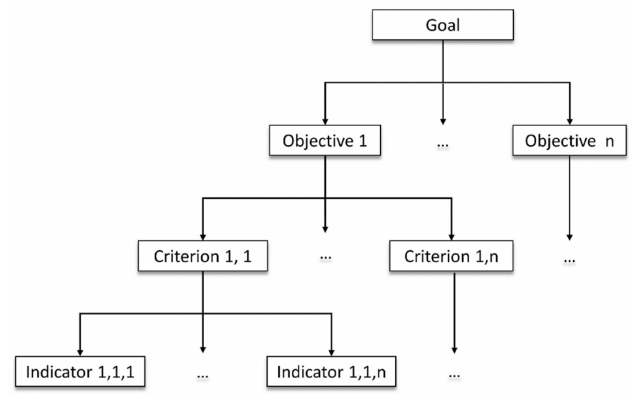
Figure 1. Generalized structure of a set of objectives